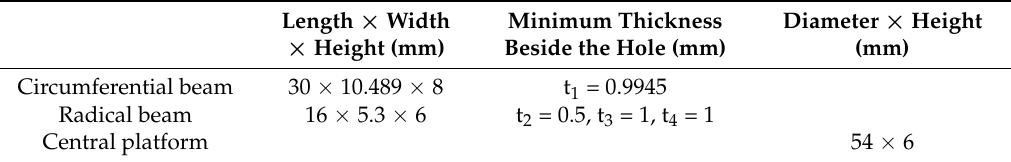
Table 2. Basic dimensions of the novel six-axis wrist sensor